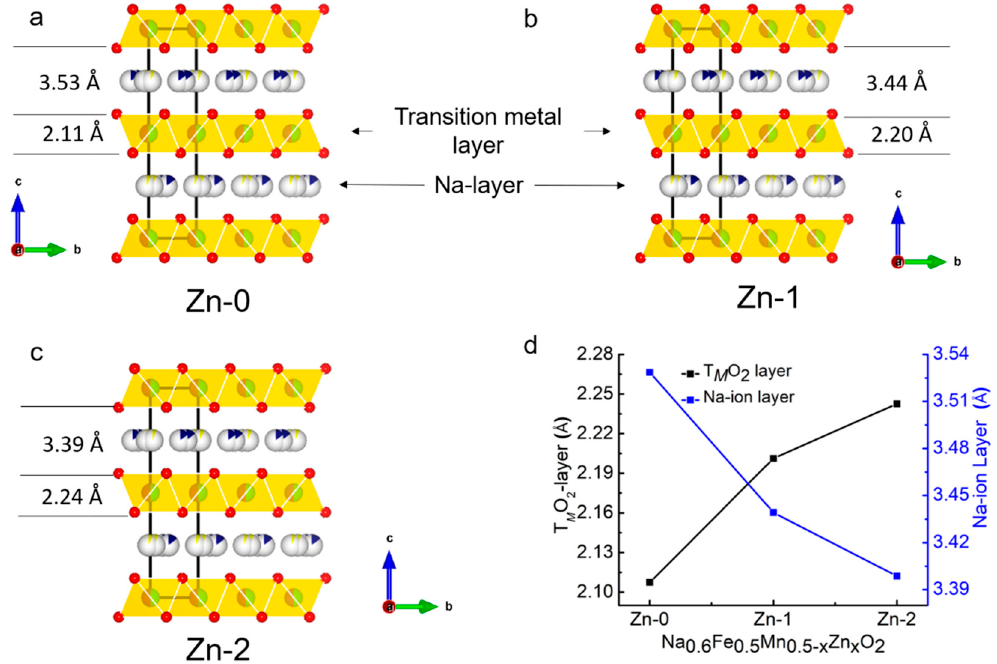
Figure 5. Schematic of layered crystal structure of ( a ) Zn-0 ( b ) Zn-1 and ( c ) Zn-2 cathode showing Na- and TMO 2 -layer thickness value. ( d ) Represents the relationship of TMO 2 slab and Na-layer thickness for Zn-0, Zn-1 and Zn-2 cathode respectively.